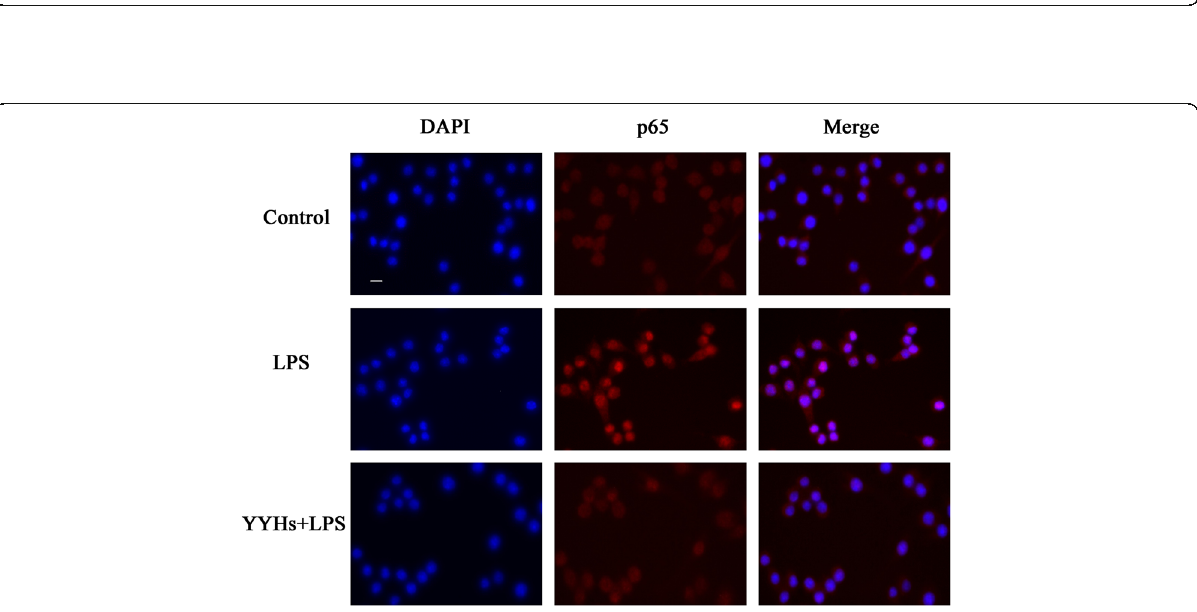
Fig. 5 Effect of YYHs on NF- κ B activation in RAW 264.7 cells. The cells were seeded in a 6-well culture plate, and treated with YYHs for 1 h and followed by stimulated with LPS for another 1 h. After treatment, fixed cells were incubated with p65 antibody and Cy3-conjugated secondary antibody, and nuclei were stained with DAPI. The images were obtained by fluorescence microscopy and overlay (Control, untreated cells; LPS, LPS (1 μ g/ml) only; YYHs+LPS, YYHs (50 μ g/mL) +